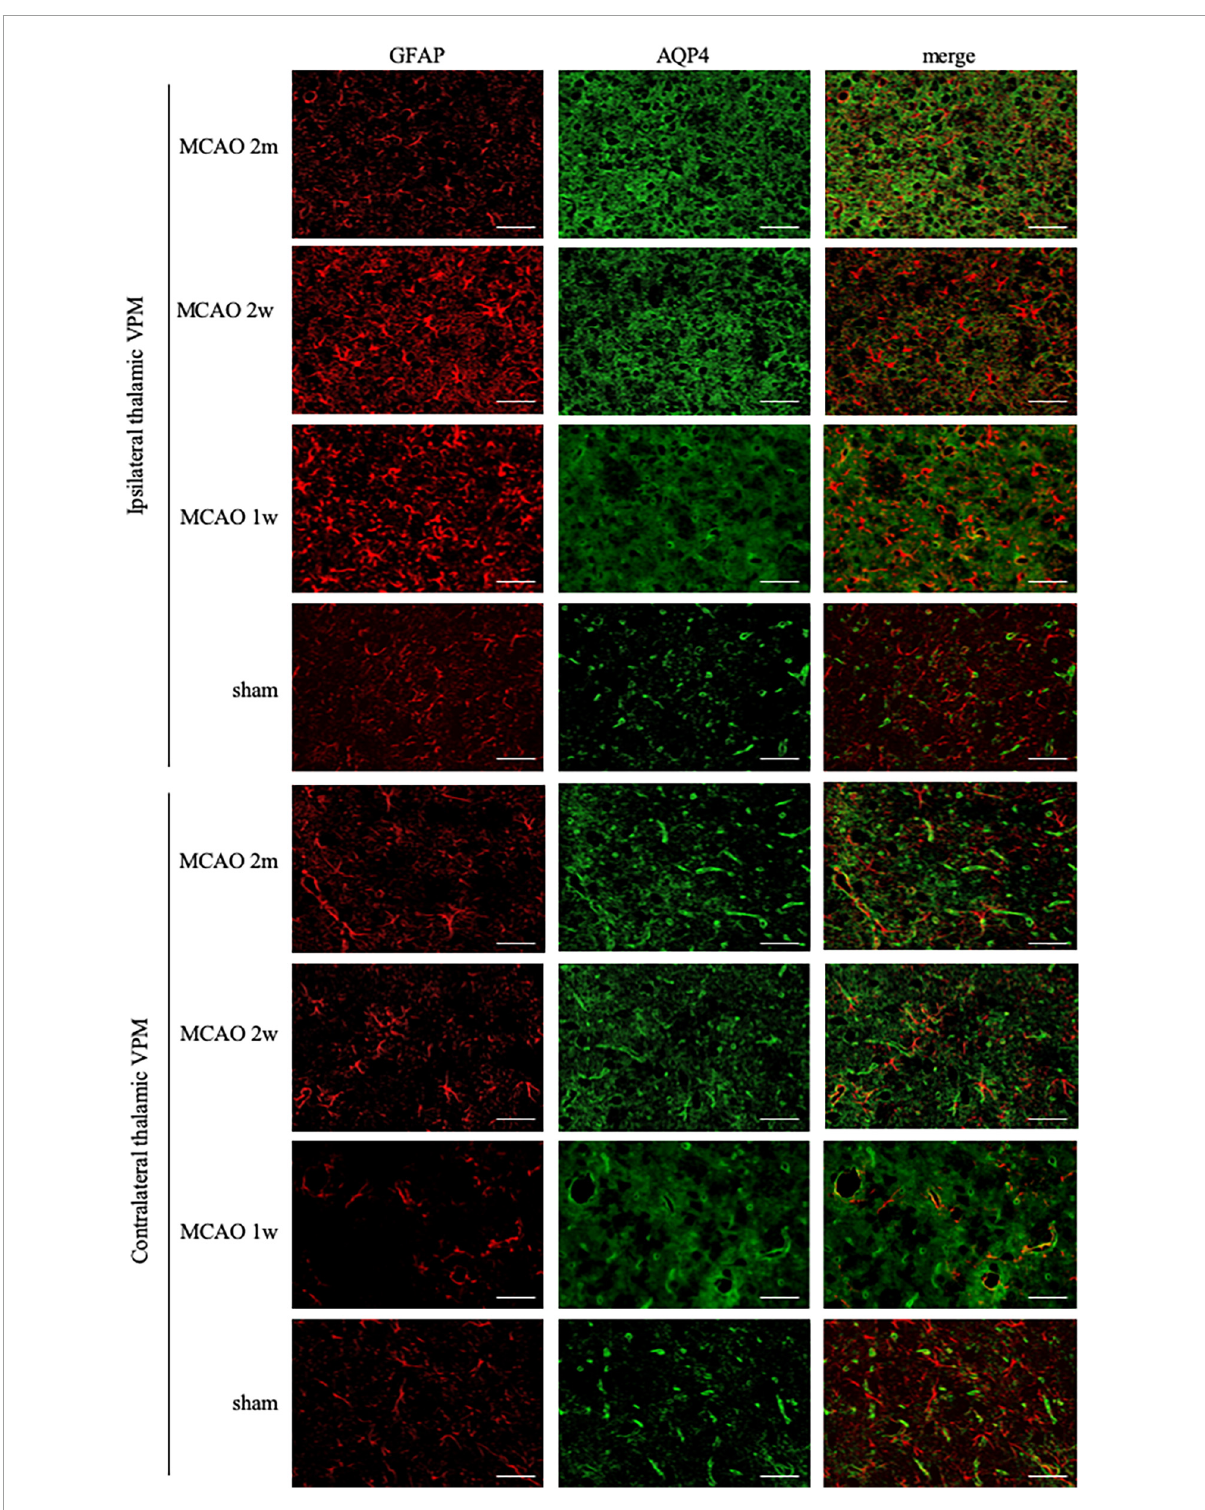
FIGURE2 GFAP + AQP4 double-label staining in the thalamus VPN. Astrocyte activation (GFAP, red) was obvious in the ipsilateral thalamic VPN at the 1st week, the 2nd week, and the 2nd month after MCAO, compared with the contralateral thalamus VPN. At the 2nd week and the 2nd month after MCAO, most of the AQP4 (green) in the ipsilateral thalamus VPN had been dispersed in the brain parenchyma and the AQP4 polarization decreased. Bar = 50 µ m. GFAP, glial fibrillary acidic protein; AQP4, aquaporin 4; VPN, ventroposterior nucleus; MCAO, middle cerebral artery